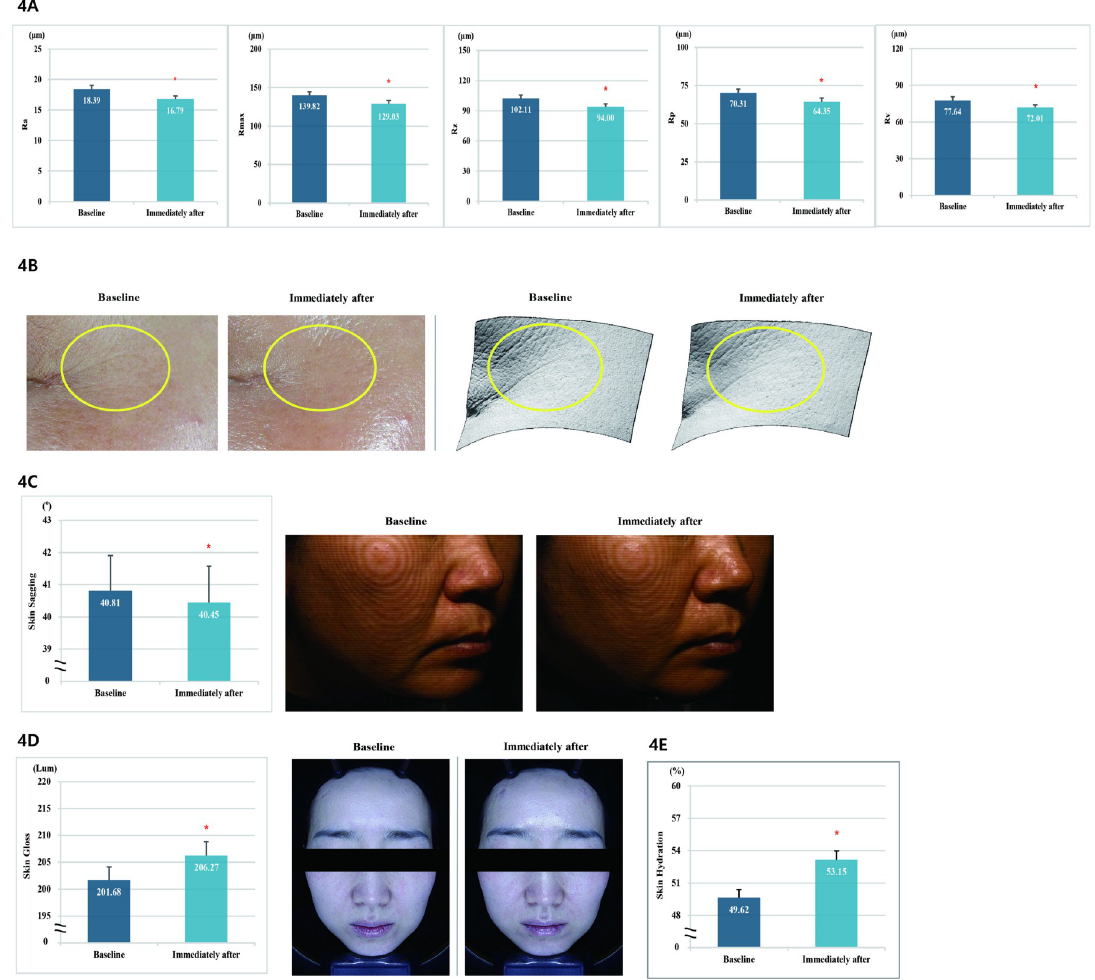
Fig 4. (A) Measurement of Ra, Rmax, Rz, Rp, and Rv parameters. (B) Polarized and 3D images of Crow’s feet after 4 weeks of product use and 1 week after discontinuation. (C) Effect on skin color improvement after 4 weeks of product use and 1 week after discontinuation and cross-polarized image of skin color in hyperpigmented